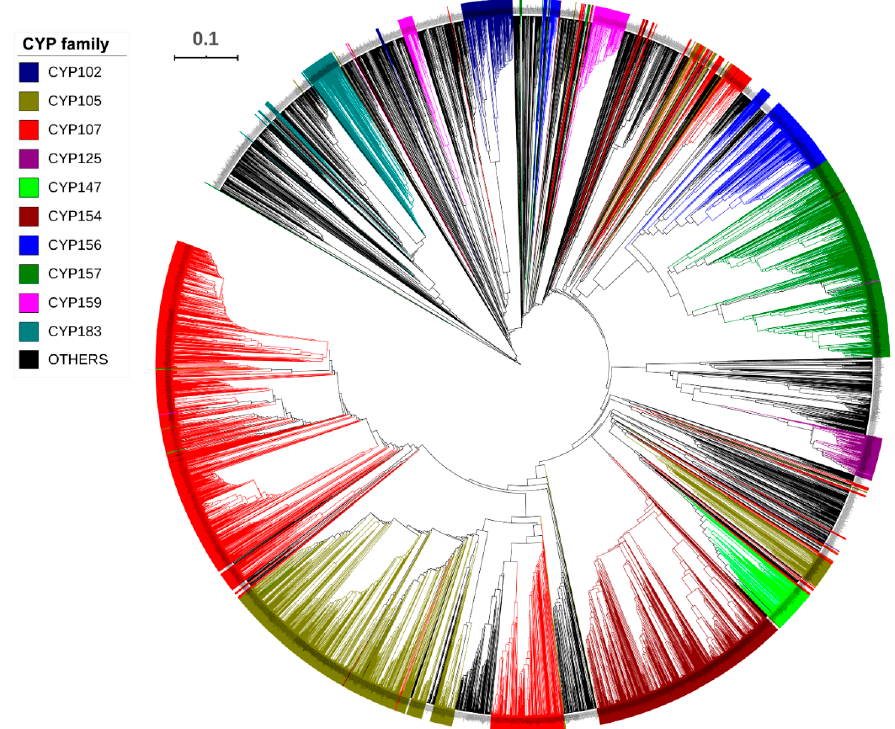
Figure 1. Phylogenetic analysis of Streptomyces P450s. In total, 5 460 P450s were used to construct the tree and the dominant P450 families are highlighted in different colors and indicated in the figure. A high-resolution phylogenetic tree is provided in Supplementary Dataset 2.